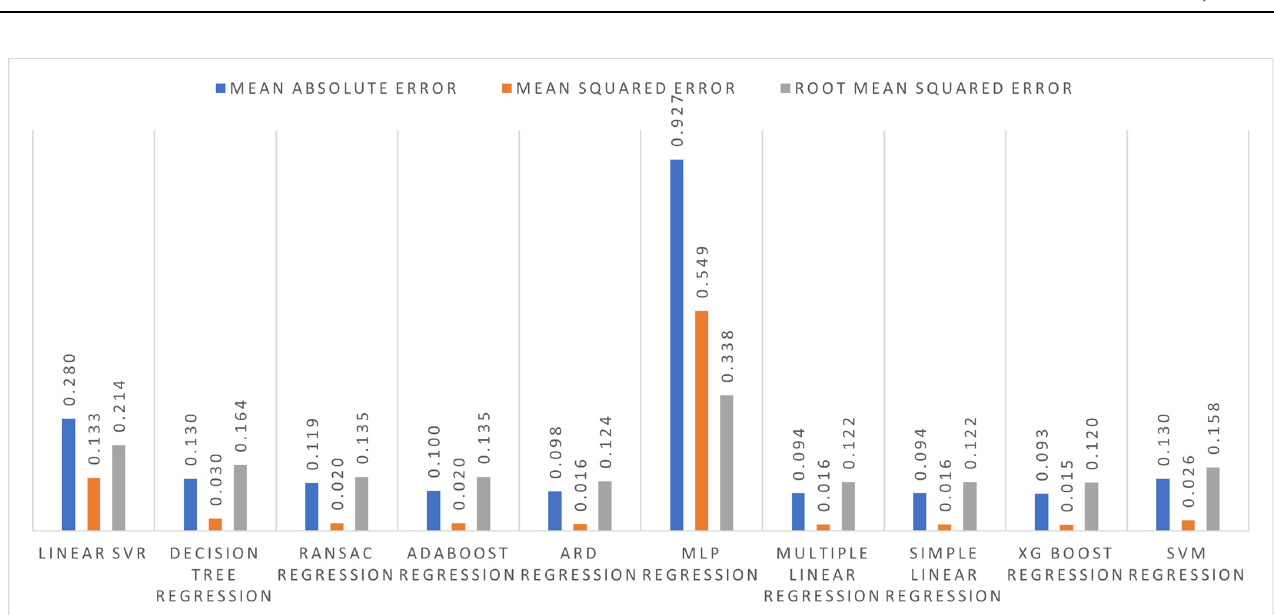
Figure 8 . Errors in 10-fold cross-validation of regression algorithms. Figure 8. Errors in 10-fold cross-validation of regression algorithms.